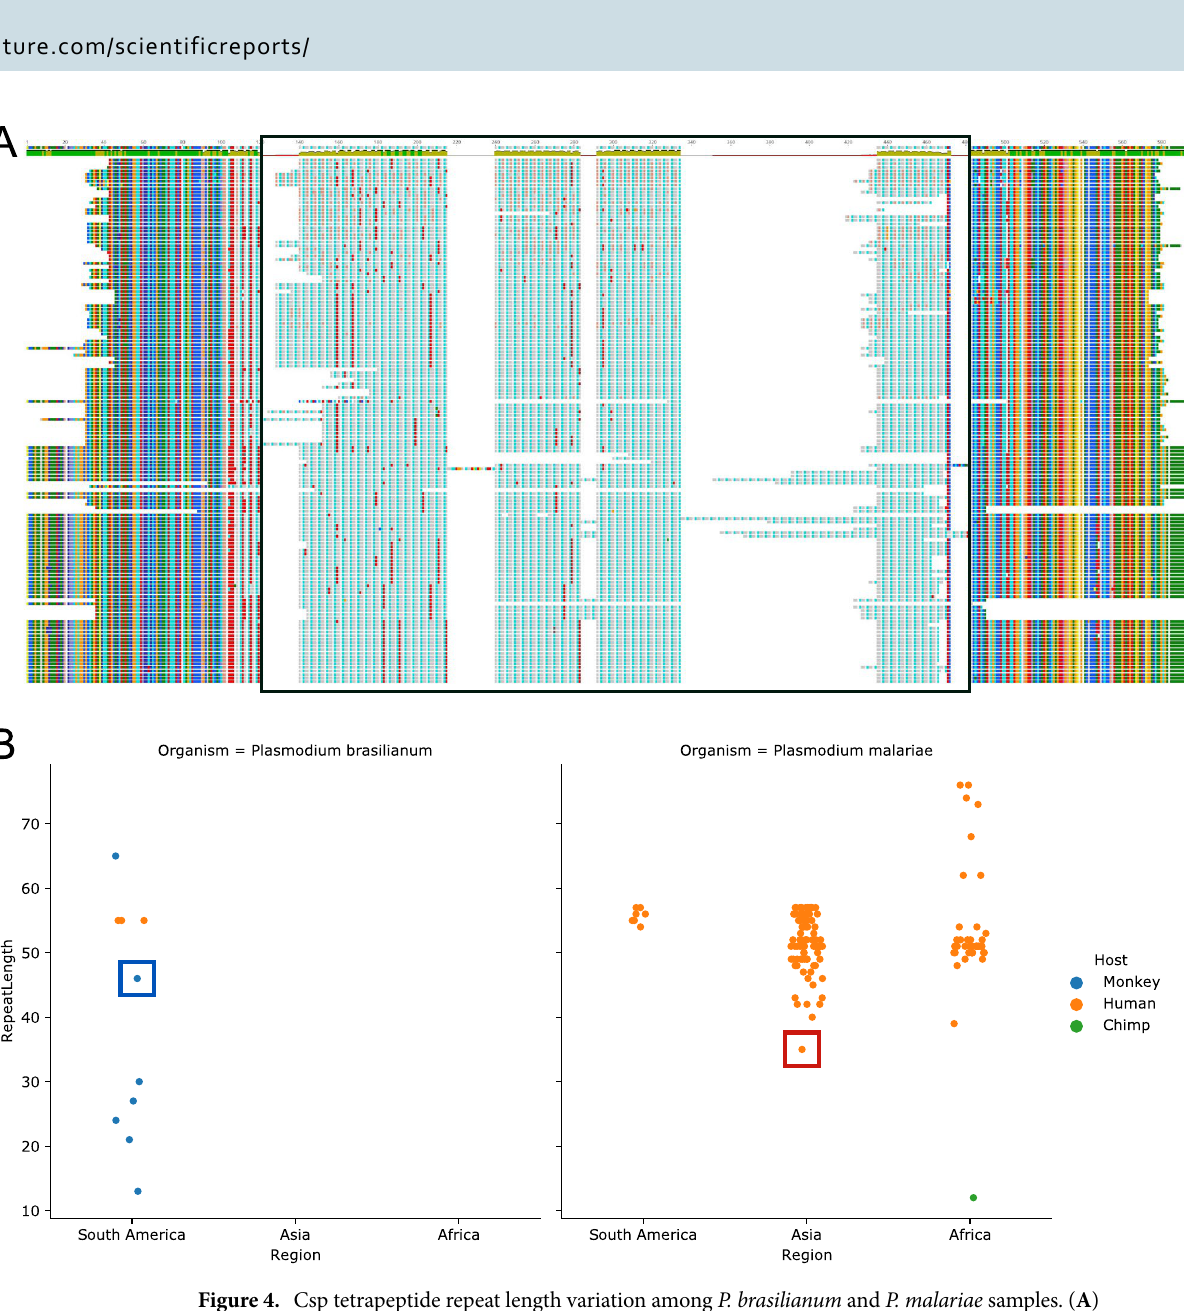
Figure 4. Csp tetrapeptide repeat length variation among P. brasilianum and P. malariae samples. ( A ) Multiple Sequence Analysis of the circumsporozoite protein Csp annotations from NCBI for P. malariae and P. brasilianum . The boxed-out region indicates the location of a tetrapeptide repeat (NAAG/NDAG/NAPG/ NDEG) with variable length among the samples. ( B ) Comparison of csp repeat lengths in nucleotides between P. malariae and P. brasilianum in samples from different continents and hosts. The P. brasilianum sample from this study and the P. malariae sample from Rutledge et al. 7 are labeled with a blue and a red box,